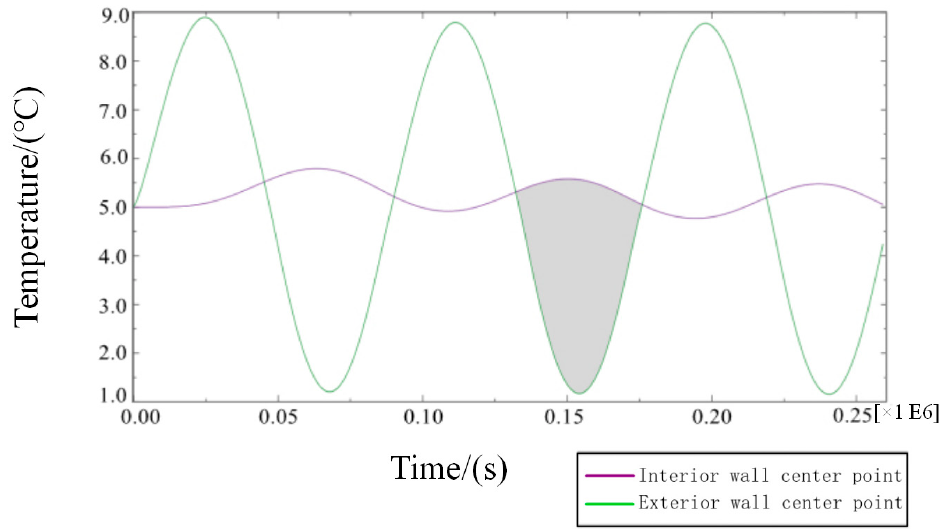
Figure 18. Temperature change curve of the internal and external walls of the transient heat transfer (low temperature).